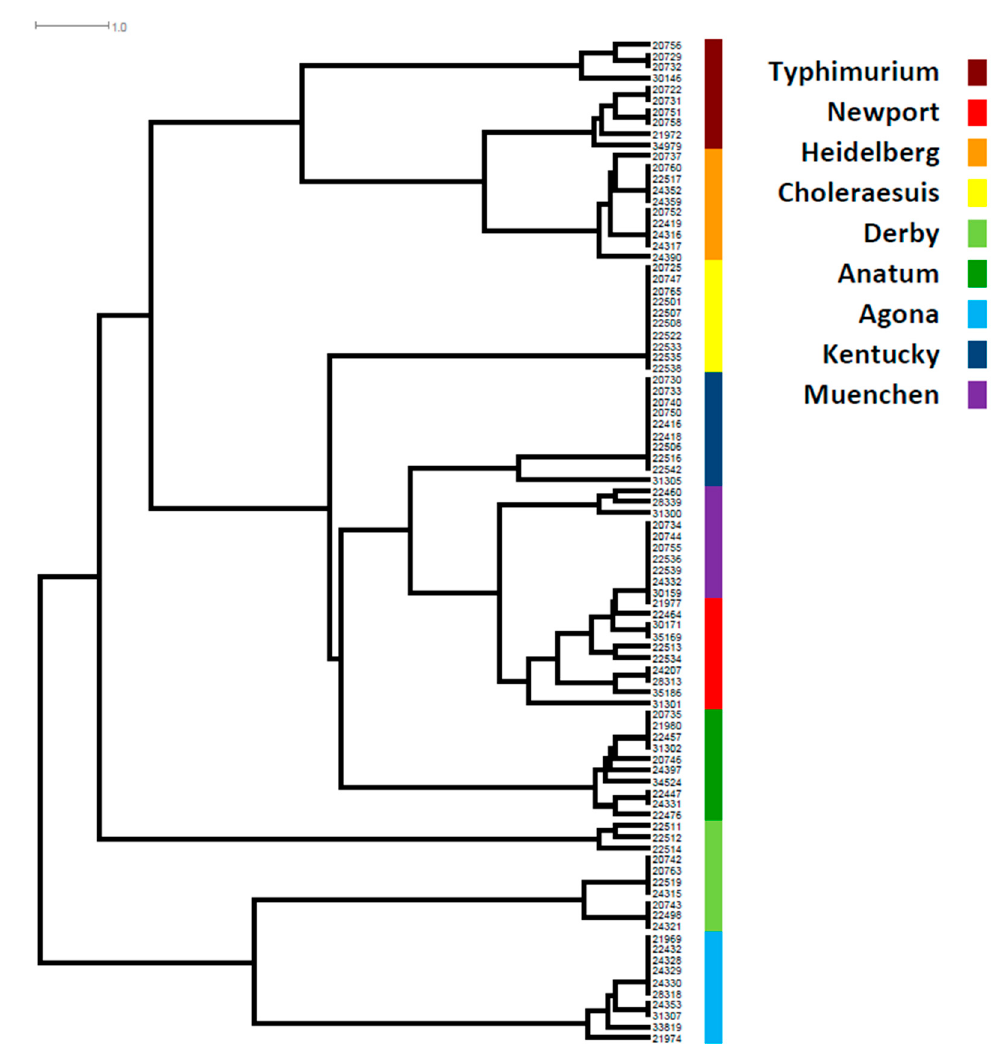
Figure 1. SPI phylogenetic tree in top 9 Salmonella serotypes. The color codes are given on the right of the figure. SPI phylogenetic tree was based on presence and absence of genes in each of SPIs and the length of each horizontal line in the tree refers to the number of gene differences among isolates.